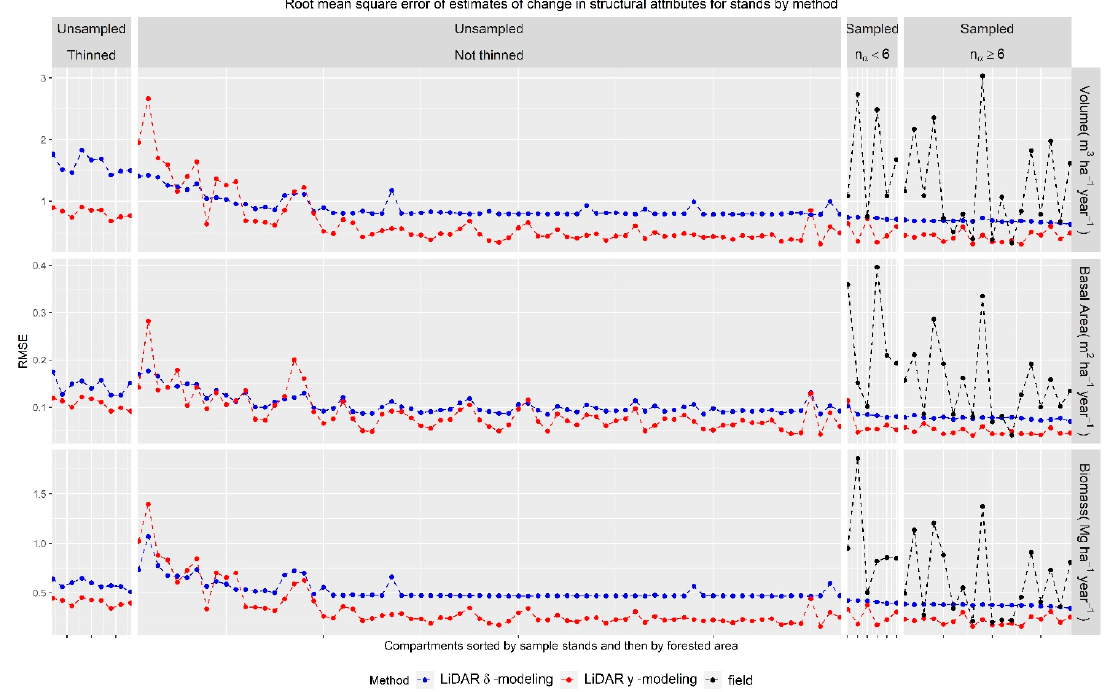
Figure 4. Values of RMSE δ (blue), RMSE y (red) and SE f (black) for the stand-level estimates of V, BA and B.